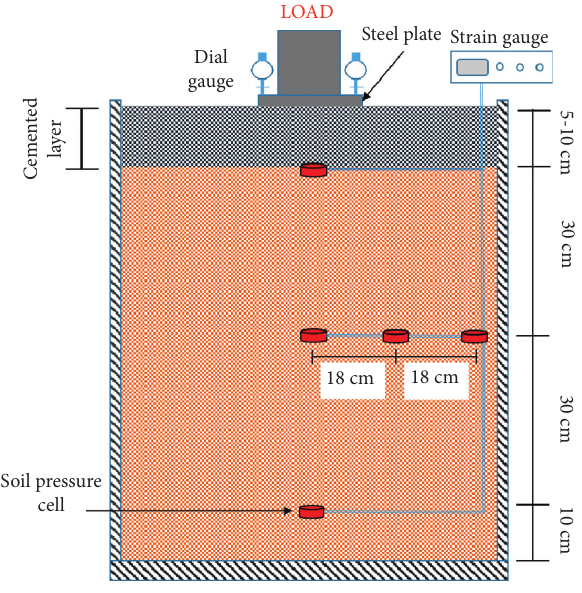
Figure 3: Diagram of the plate load